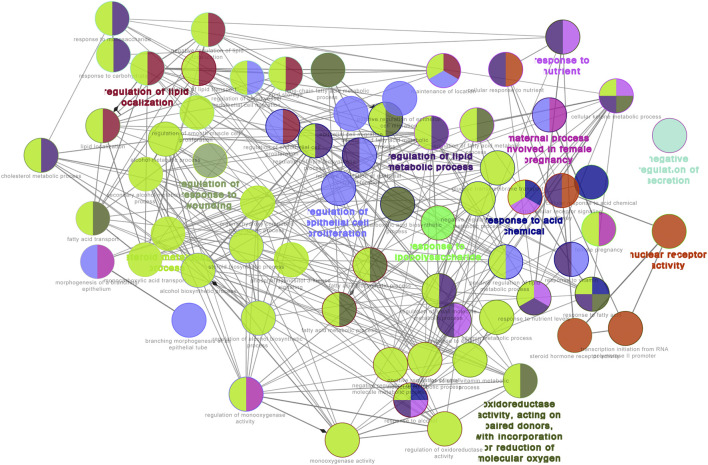
GO functional network for 73 target proteins. Nodes:GO terms; bigger nodes indicated smaller p values;the two-point line represents the correlation between functions, and the larger the kappa coefficient, the thicker the line.